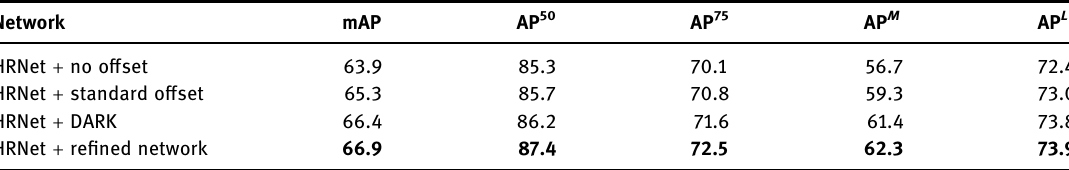
Bold values represent the best results for the corresponding